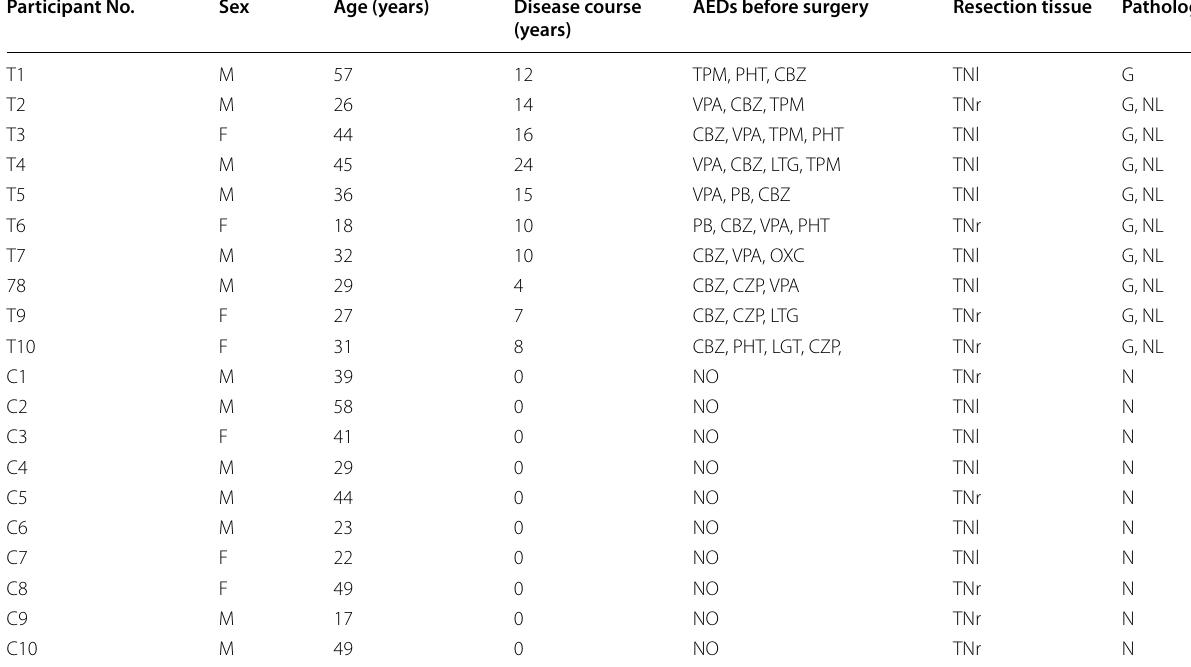
T TLE, C Controls, F female, M male, AEDs anti-epileptic drugs, PB Phenobarbital, CBZ carbamazepine, VPA valproic acid, PHT phenytoin, CZP clonazepam, OXC oxcarbazepine, LEV levetiracetam, LTG lamotrigine, TPM topiramate, TN temporal neocortex, l left, r right, NL neuronal loss, G gliosis, N normal